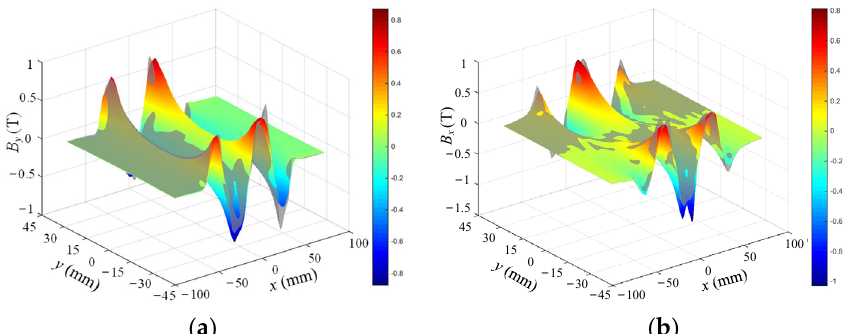
Figure 5. Comparison of analytical and simulation results of magnetic flux density: ( a ) y component; ( b ) x component.